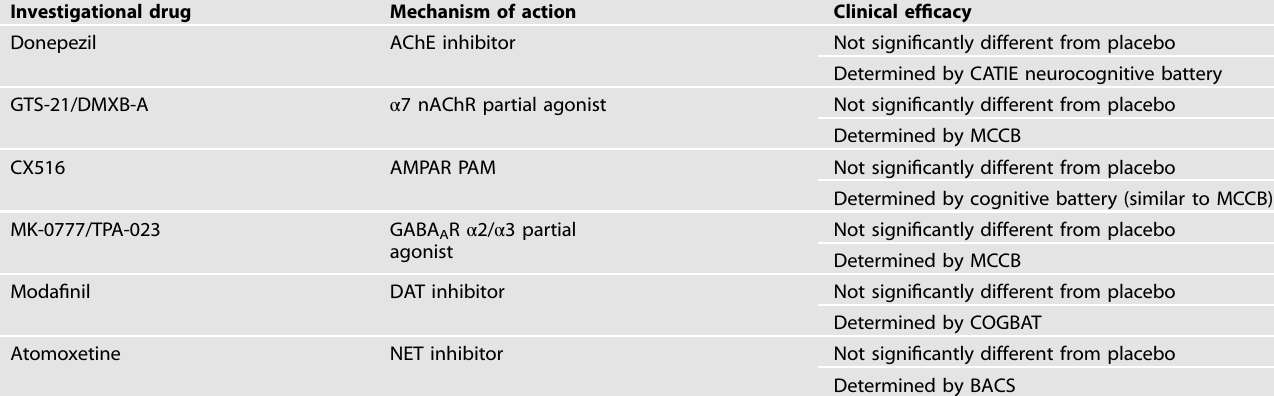
Table 1. Investigational schizophrenia therapeutics with nootropic ef fi cacy in the rodent novel object recognition task do not possess clinical pro- cognitive